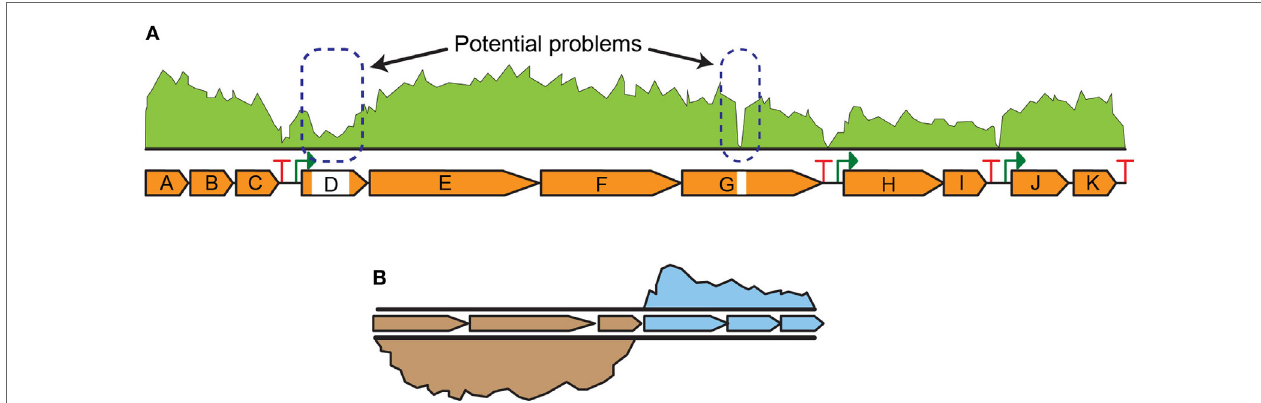
FiGURe 3 | Next-generation sequencing data examples for (A) engineered strain QA/QC indicating potential problems in transcript levels in parts of the pathway and (B) comparative RNA-seq analysis indicating higher expression of three genes in one strain relative to another strain